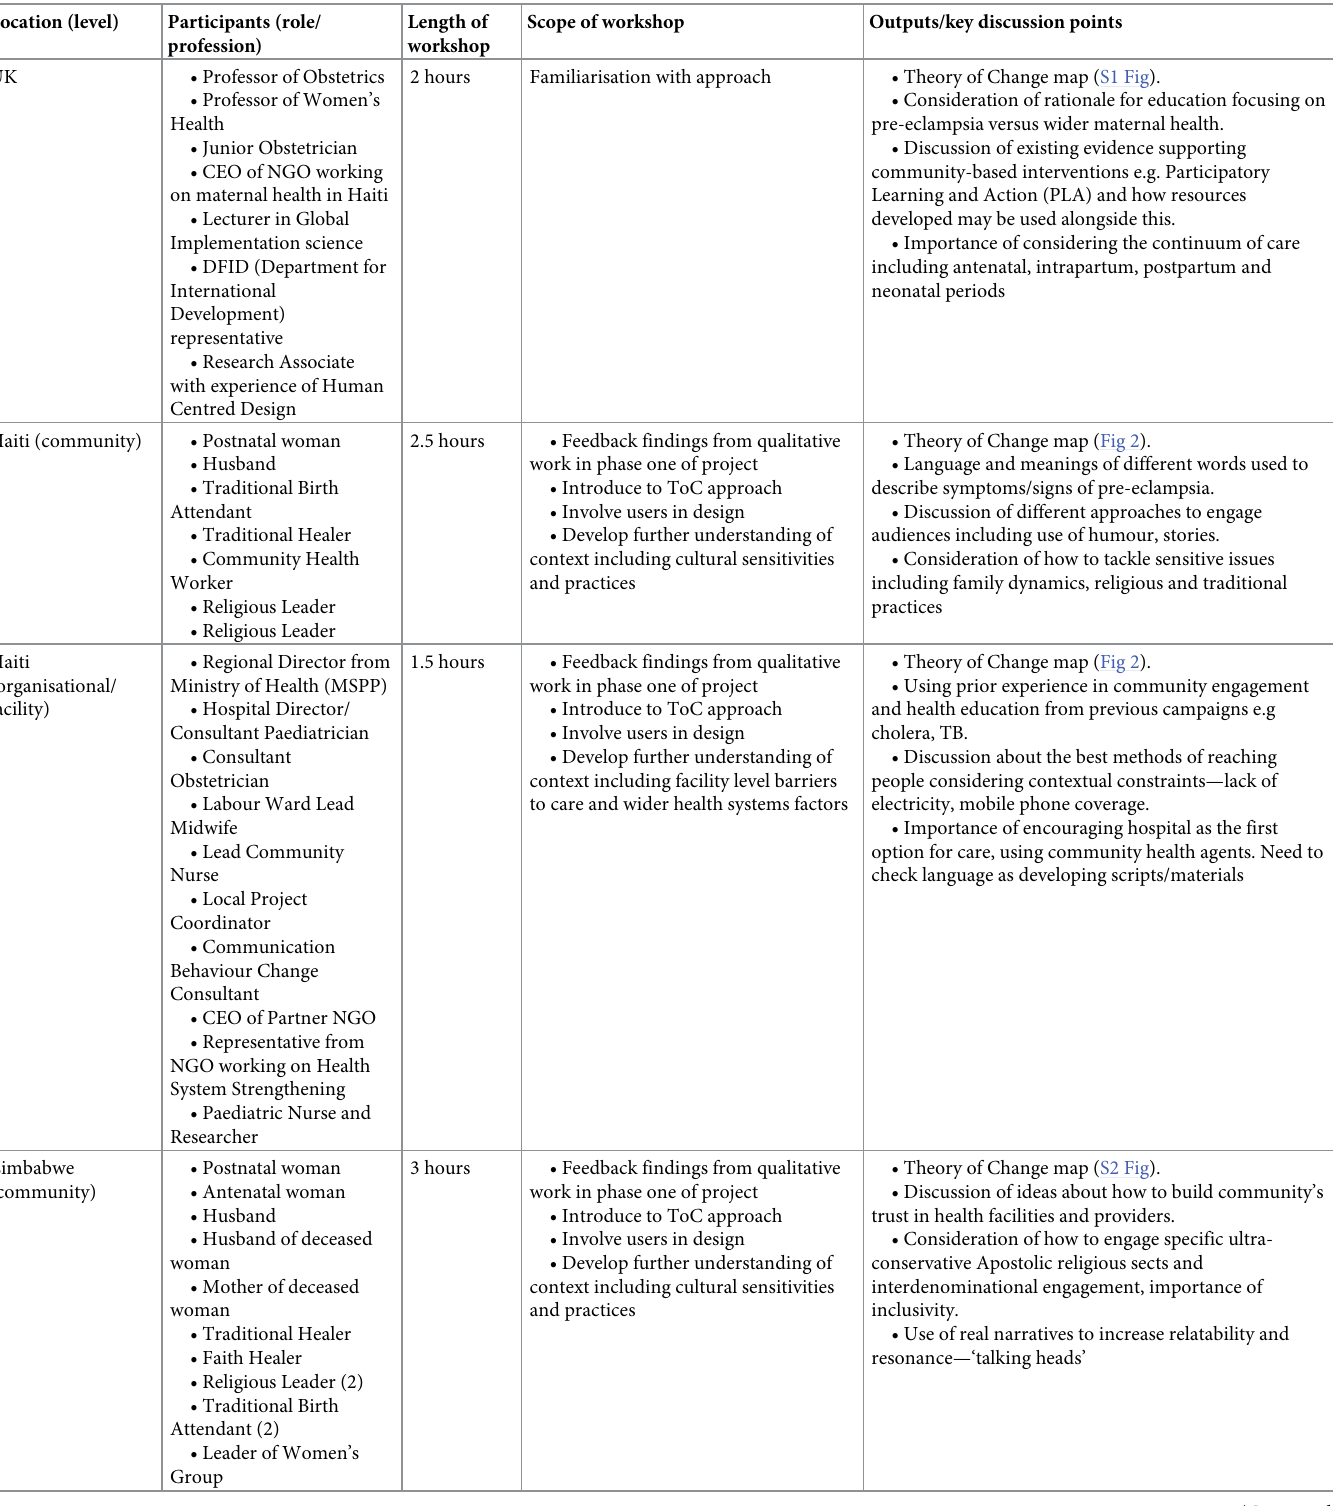
Table 1. Summary of Theory of Change